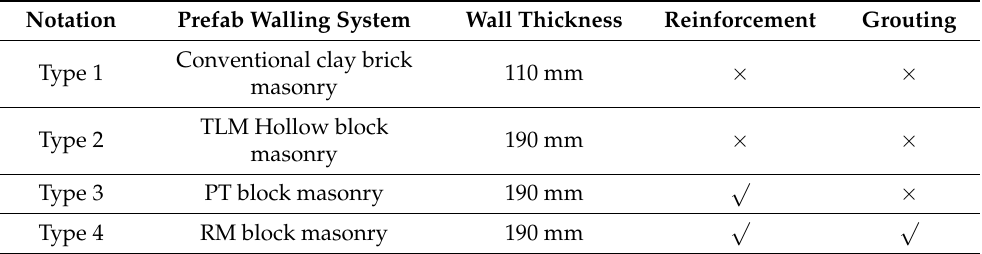
Table 1. Considered masonry walling systems.